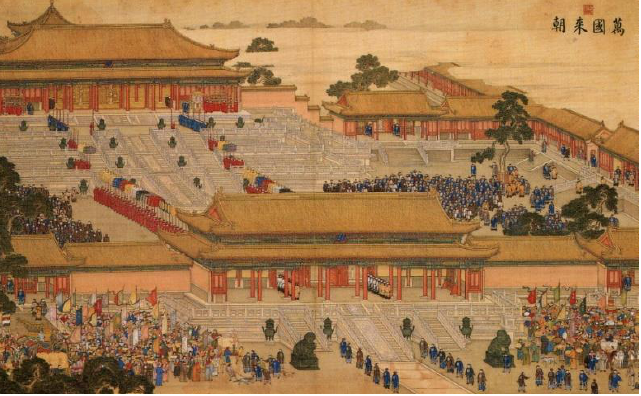
Figure 13. Hall of Supreme Harmony, 万国来朝图 , from the collection of The Palace Museum.